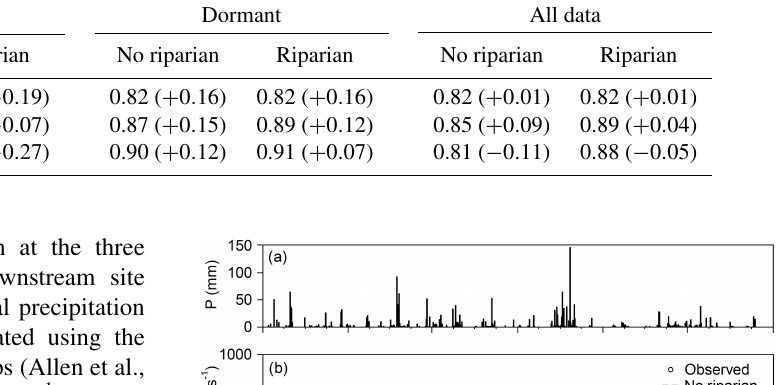
Table 3. Comparison between model calibrations including and excluding the riparian compartment. Log-transformed Nash–Sutcliffe (NS) model efficiency coefficient and relative volume differences (RVDs in %) of observed versus simulated streamflow (in parentheses) at the upstream, midstream, and downstream sites for vegetative, dormant, and whole calibration periods (September 2010–August 2012). Negative RVD values indicate an overestimation of modeled flow volumes compared to observed flow volumes, while positive RVD values indicate the opposite. The NS model efficiency values are not shown because they were similar to log(NS) values. Vegetative Dormant All data No riparian Riparian No riparian Riparian No riparian Riparian